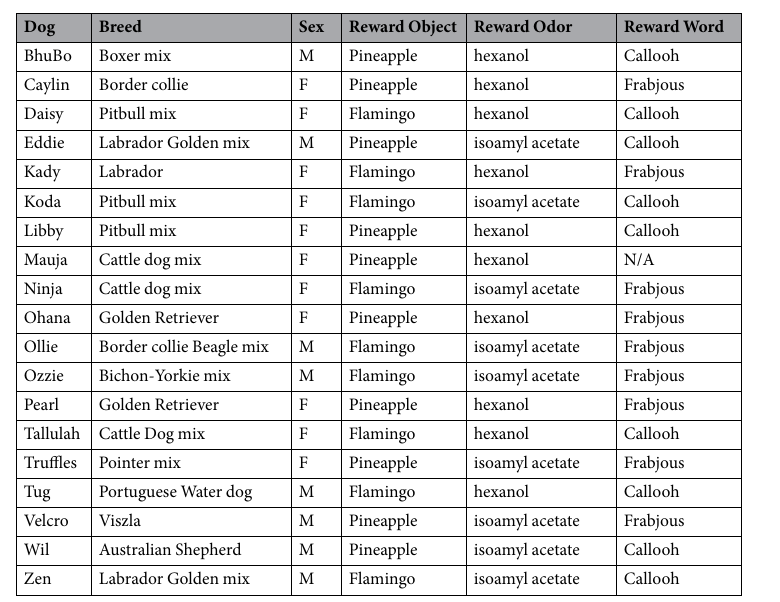
Table 1. Dogs (N = 19) and stimuli paired with reward. Dog’s names, breed, sex, and stimuli (S + ) are